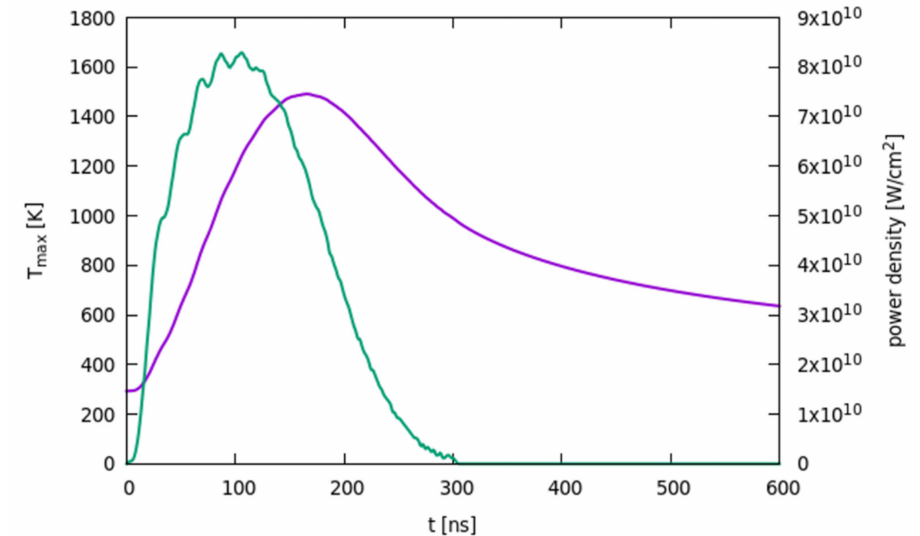
Figure 1. Global maximum temperature (purple line) as a function of the time obtained for E dens = 2.2 J/cm 2 energy density laser process of a Ni (100 nm) + 4H-SiC stack. The power density released by the laser pulse in the Ni layer is shown as green